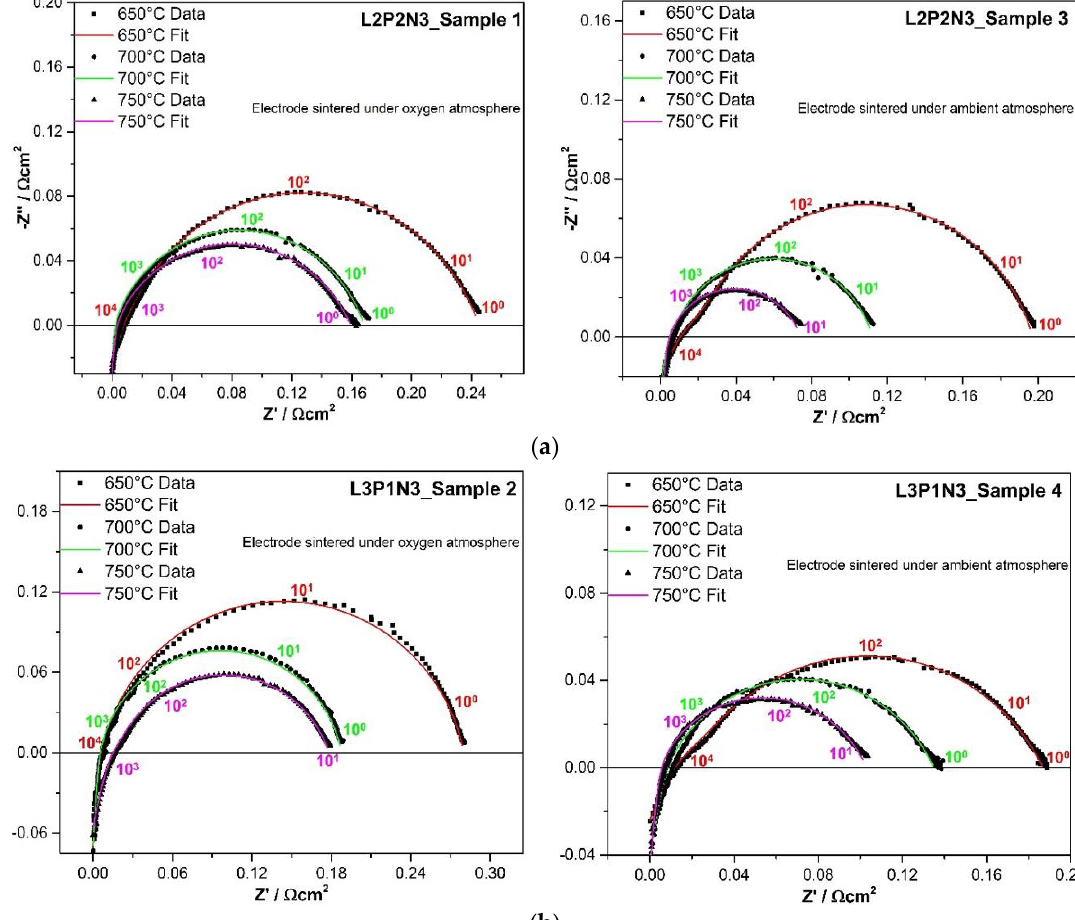
Figure 2. Nyquist plots recorded for samples ( a ) 1 and 3 (L2P2N3) and ( b ) 2 and 4 (L3P1N3). Samples 1 and 2, sintered under an oxygen atmosphere followed by slow heating, present higher corresponding area specific resistances (ASRs) than samples 3 and 4 sintered under an ambient atmosphere.